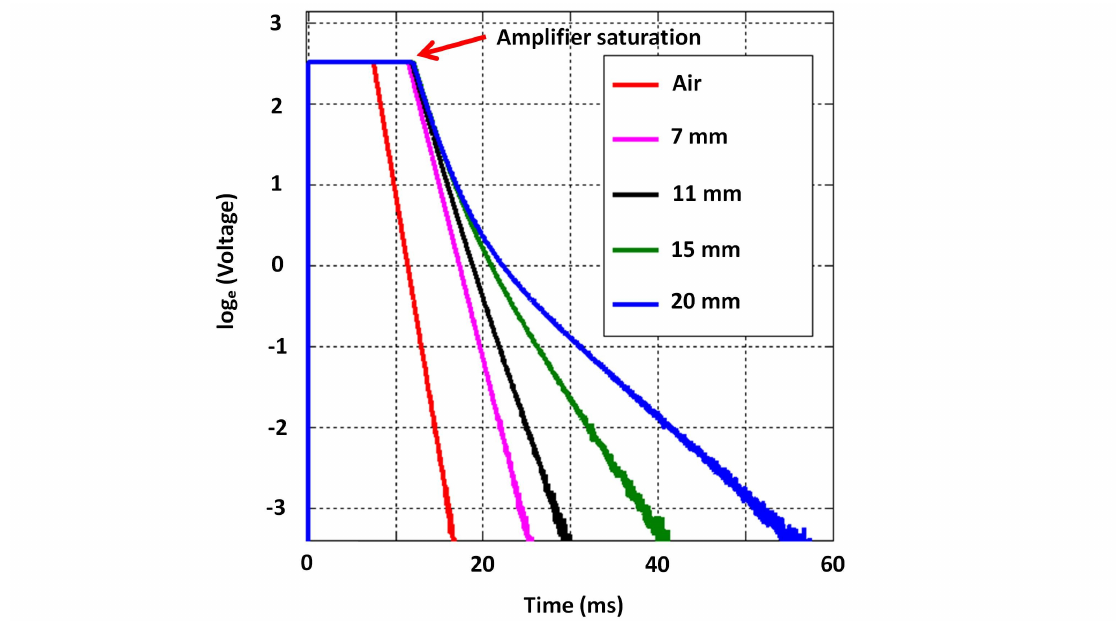
Figure 13. Signals obtained on grey cast iron calibration blocks for the full thickness range; sharp rising edges of signals are not discriminable in the ms time scale and appear to be